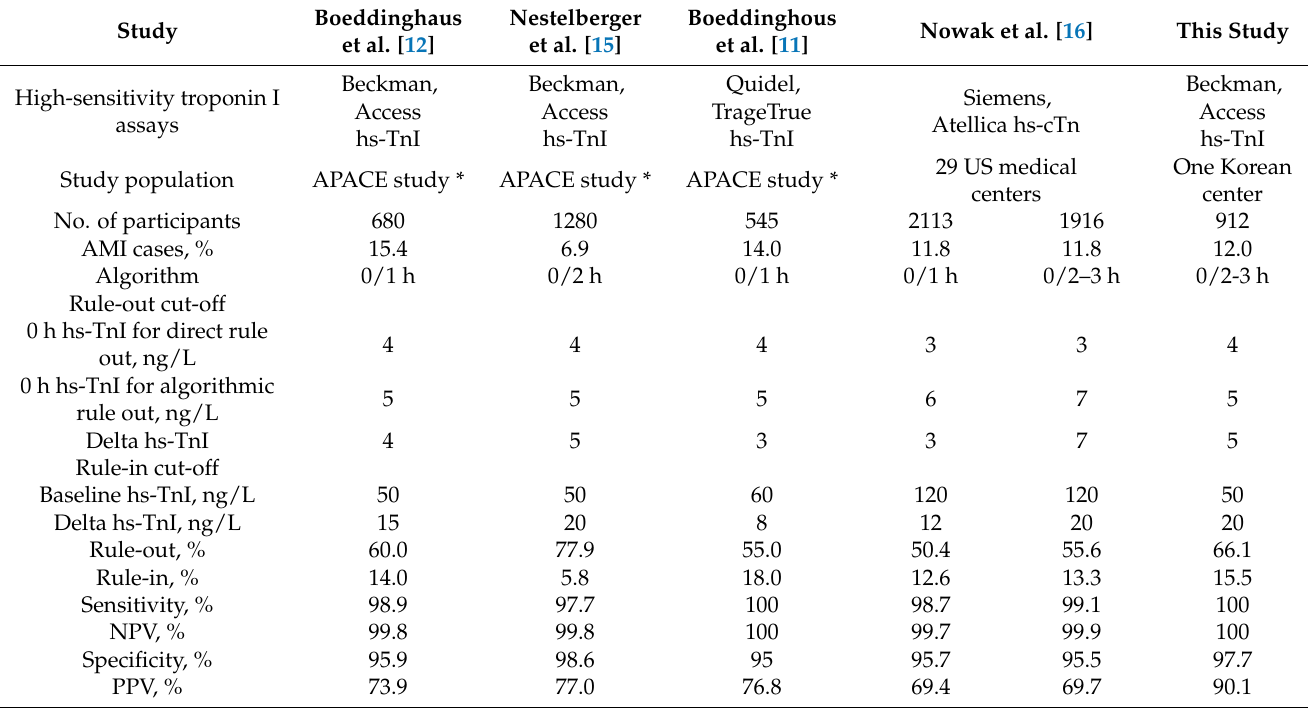
Table 3. Published data for algorithmic approaches using high-sensitivity troponin I